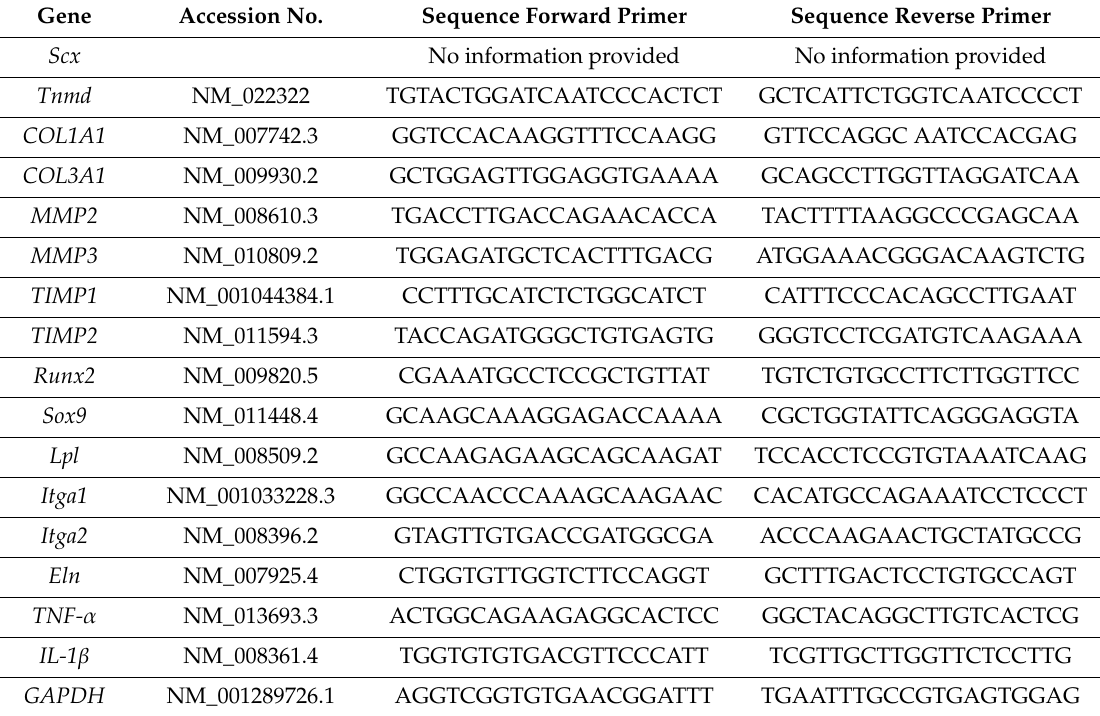
Table 1. List of